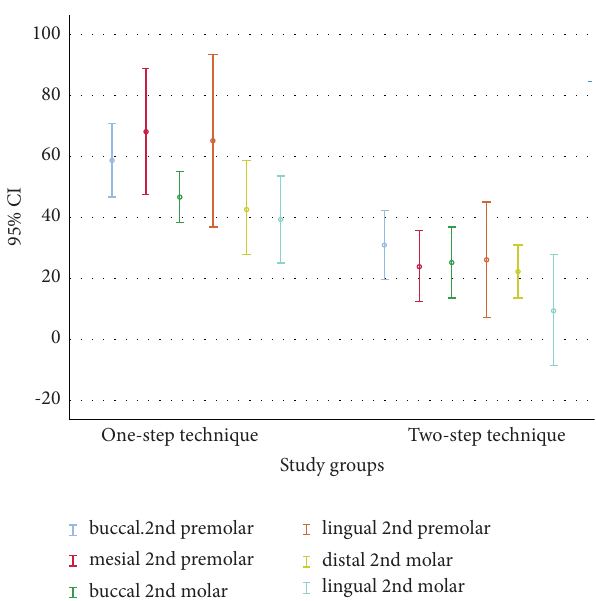
Figure 3: Te average error chart and 95% on confdence internal of one-step and two-step